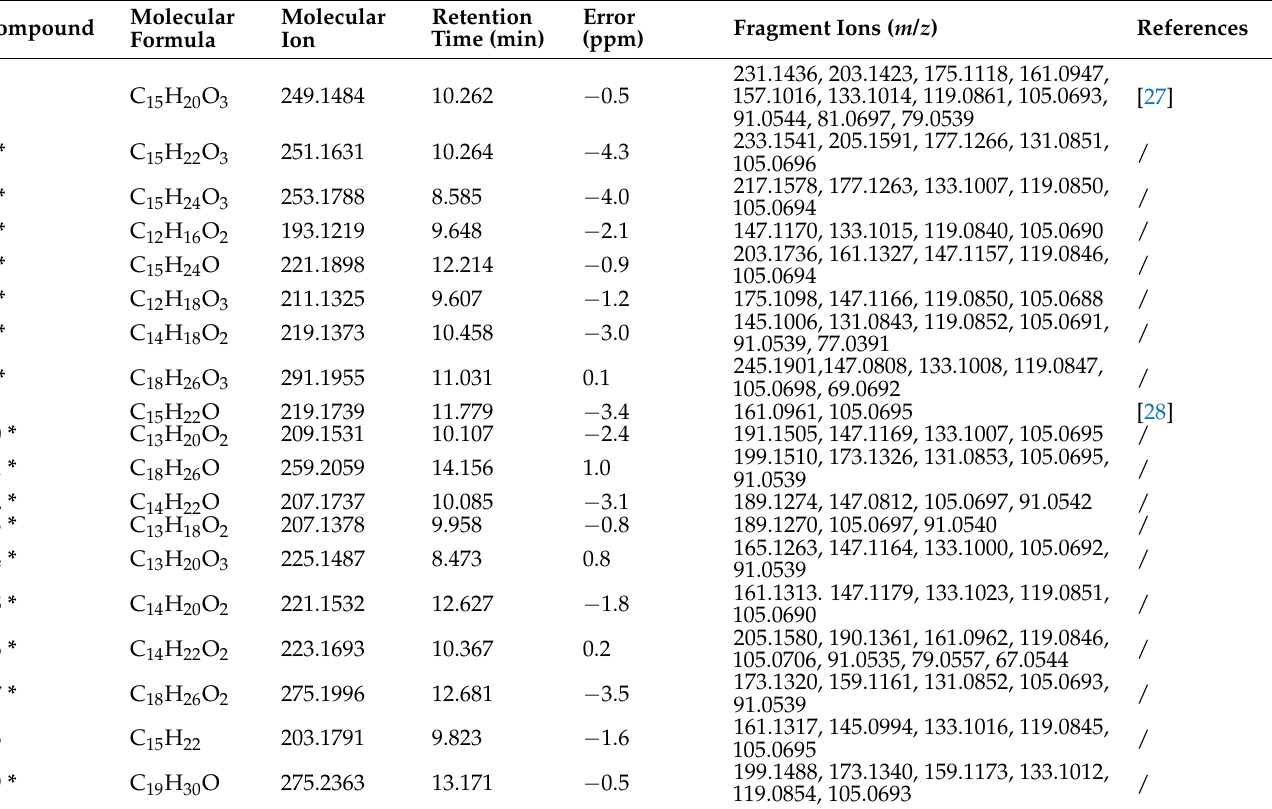
Figure 1. Molecular networking of non-alkaline ingredients isolated from Gynura divaricata (L.) DC. (GD-NAIs). The red node was identified as rupestonic acid (compound 1 ) by GNPS library search, and the green nodes remain unknown. Table 1. Detailed information on tentatively characterized sesquiterpenoids within Gynura divaricata (L.)